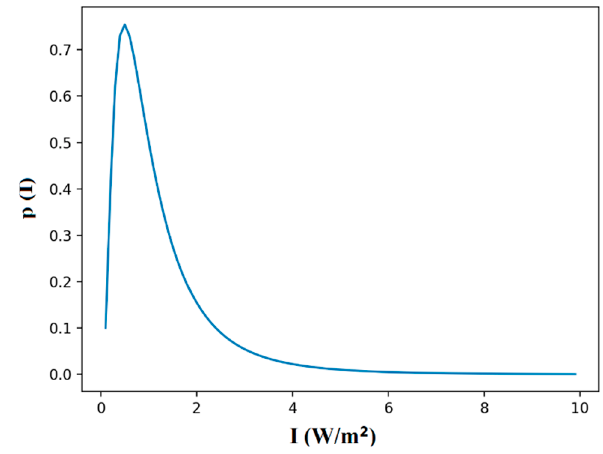
Figure 2. Probability distribution function of irradiance.